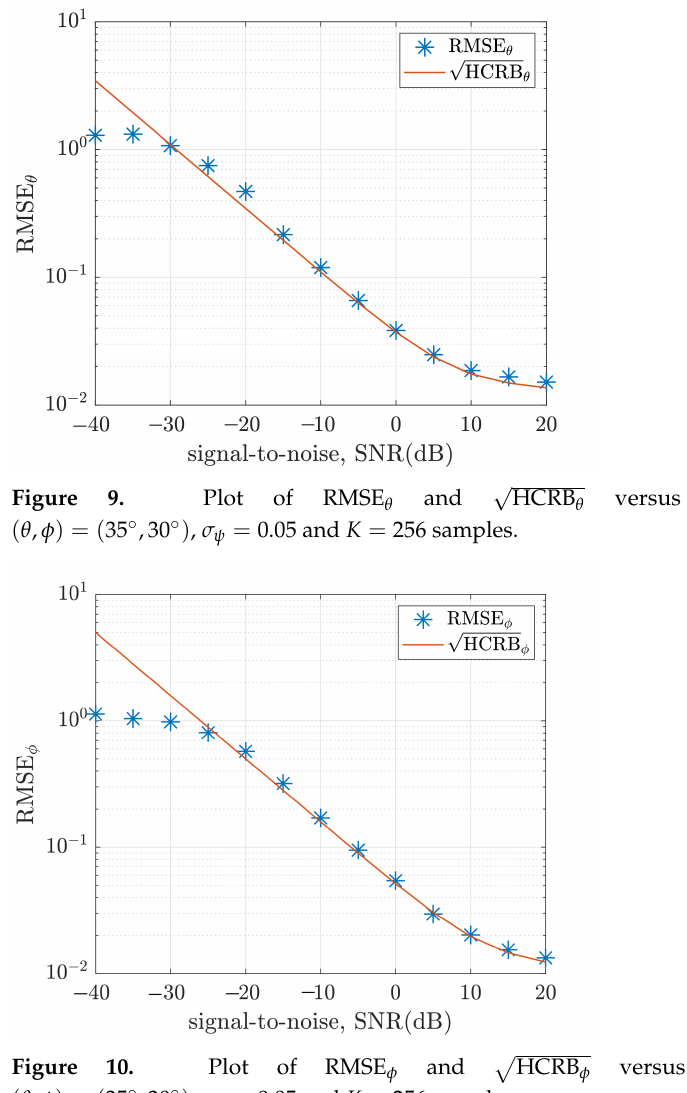
Figure 10. Plot of RMSE φ and (cid:112) HCRB φ versus signal-to-noise ratio for ( θ , φ ) = ( 35 ◦ ,30 ◦ ) , σ ψ = 0.05 and K = 256